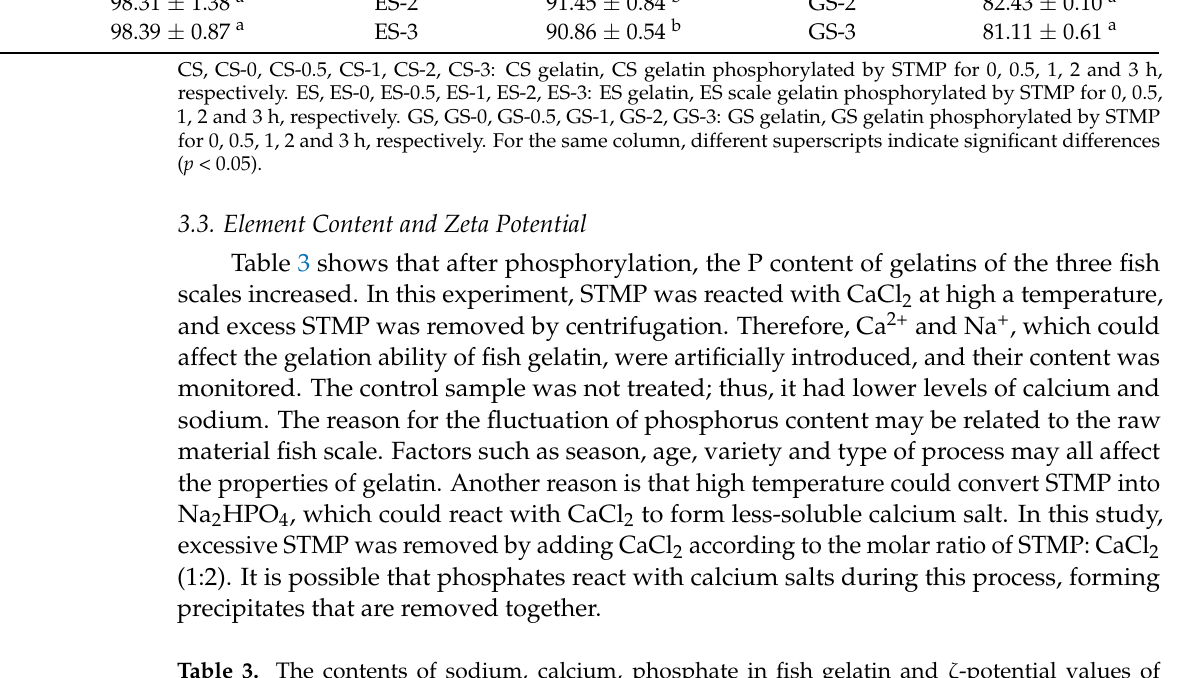
Table 3. The contents of sodium, calcium, phosphate in fish gelatin and ζ -potential values of phosphorylated fish gelatin